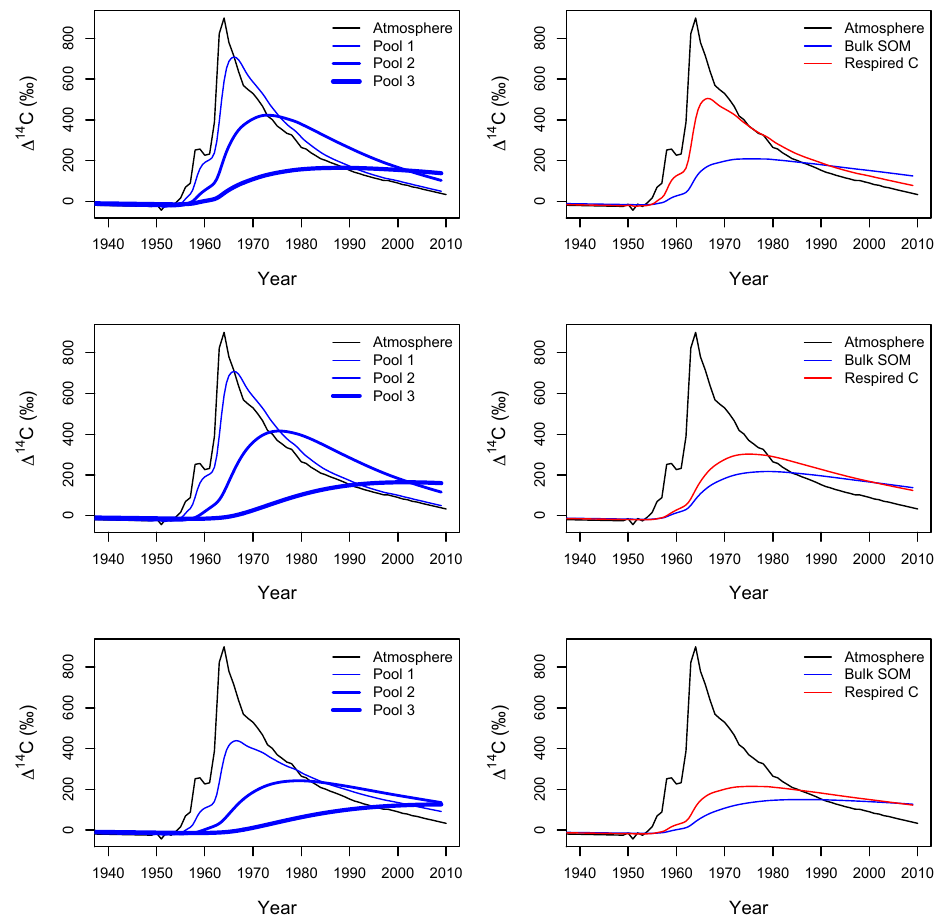
Figure 2. Predictions of pool radiocarbon, bulk soil radiocarbon, and respired carbon for three different versions of a three-pool model (Fig. 1) with parallel (upper panels), series (middle panels), and feedback structure (lower panels). This figure can be reproduced by typing example(“ThreepFeedbackModel14”) in R